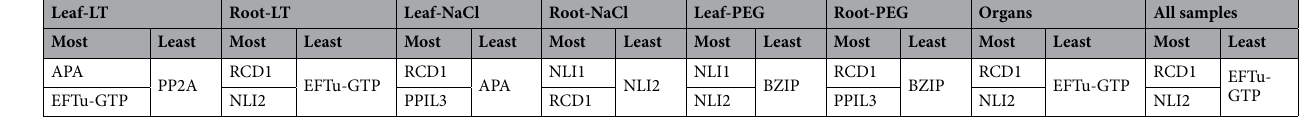
ferent treatment conditions were selected. In root samples from plants subjected to salt and low-temperature treatments, the expression of WRKY at 0 h was assumed to be 1 and was used to compare the relative expression RCD1 and NLI2 (including RCD1 + NLI2 ), and the least stable reference gene, EFTu-GTP , according to the results of the comprehensive evaluation were used to calibrate the relative expression of the WRKY , RCD1 , and NLI2 target genes, respectively. In addition to the expression pattern of the RCD1 + NLI2 combination, which was used as a reference gene, the expression pattern of WRKY was consistent. When the least stable reference gene ( EFTu-GTP ) was used to correct the target gene, the expression pattern greatly differed from the above expression pattern. In the roots of plants under salt stress, the relative expression of the WRKY target gene was validated using the two best reference genes, NLI1 and RCD1 ; the NLI1 + RCD1 combination; and the least